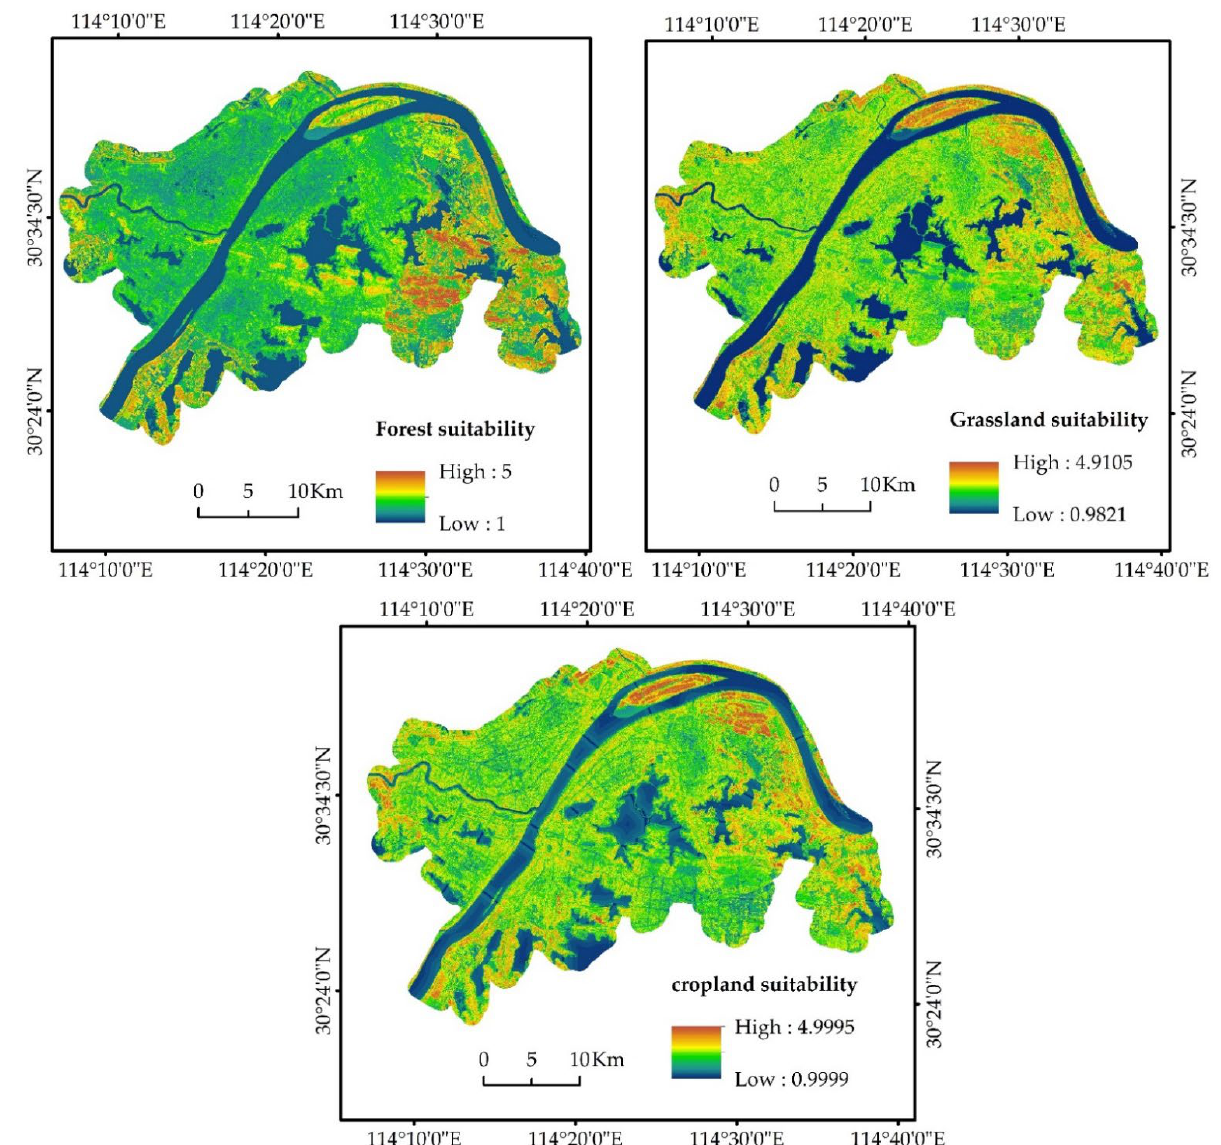
Figure 2. Spatial patters of the suitability of cropland, grassland, and forest in Wuhan urban areas in 2020.